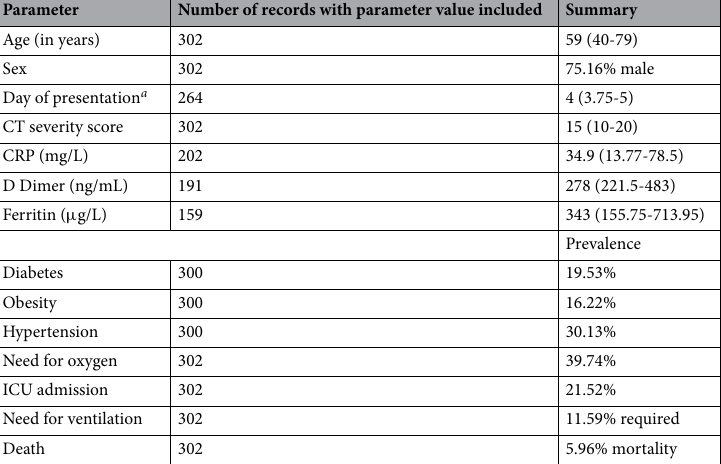
Table 1. Summary of parameters in the MGMCH dataset and the number of records that have the parameter recorded. Each summary data is presented as either a percentage or a median value (interquartile range). a Number of days passed from the symptom